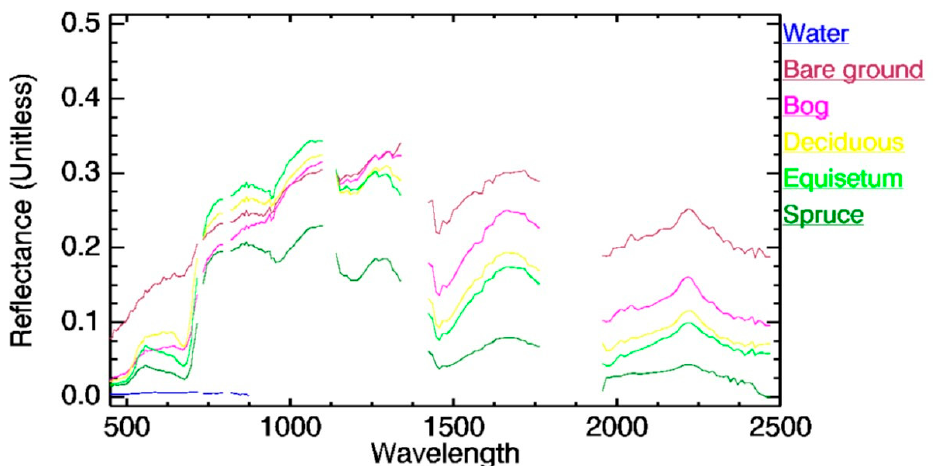
Figure 7. Averaged spectra extracted from training and test areas for all classification categories. Note that negative values for water were removed for better visual comparison of the spectra.